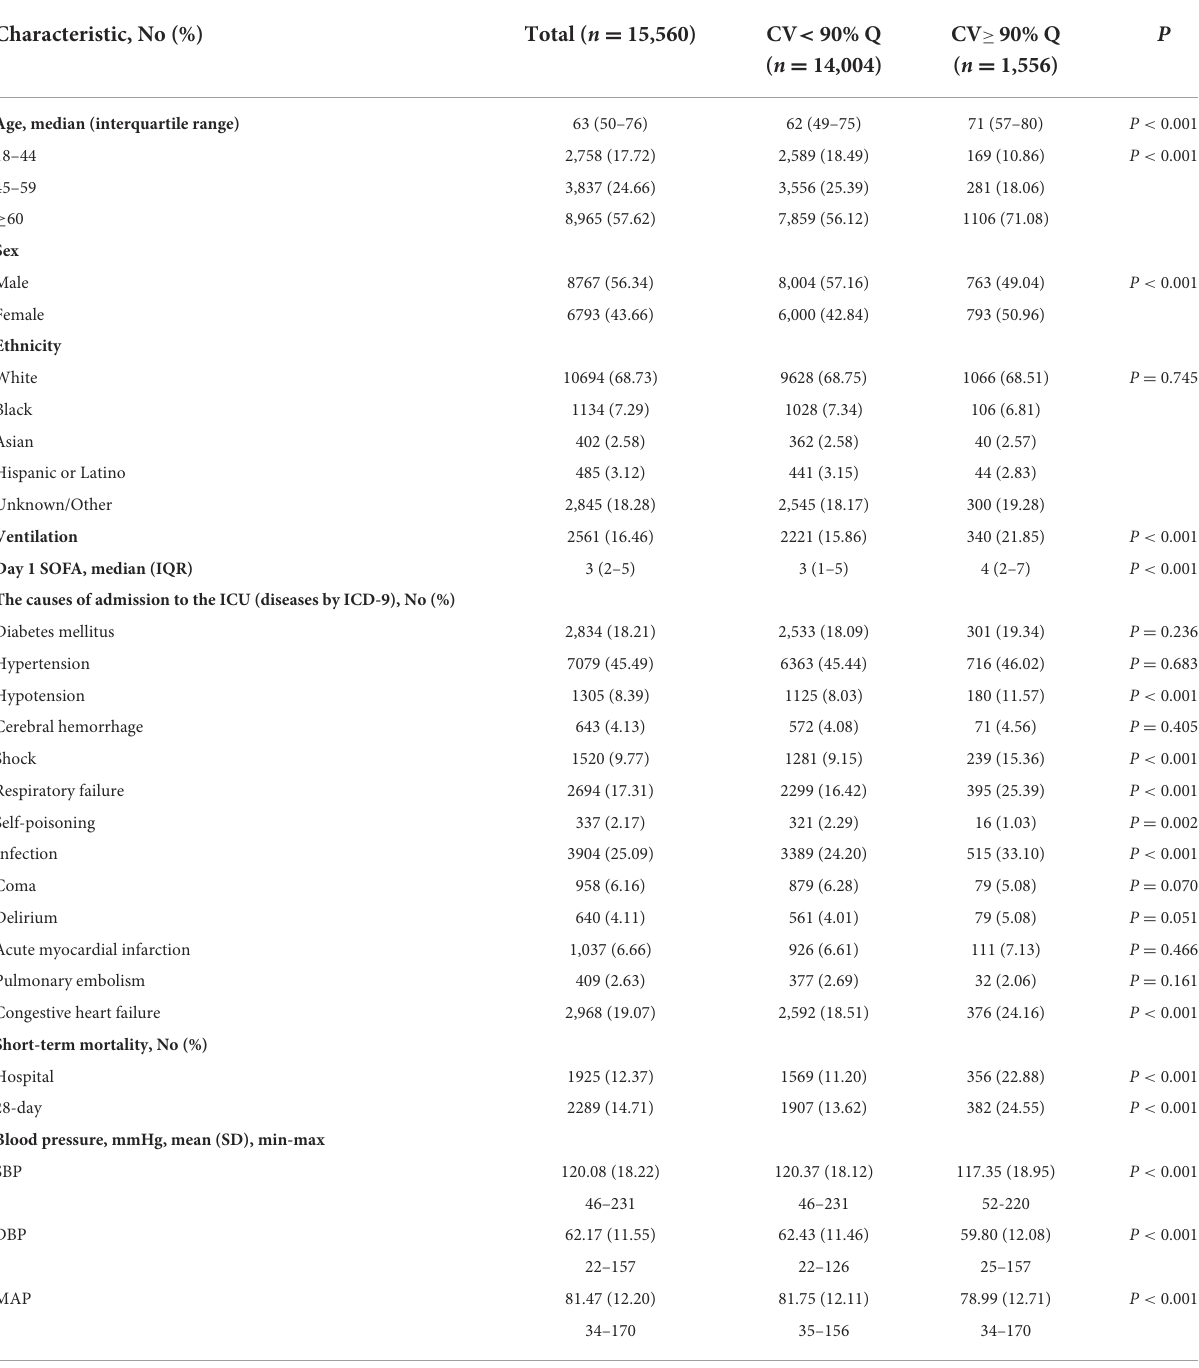
TABLE 1 Characteristics of study